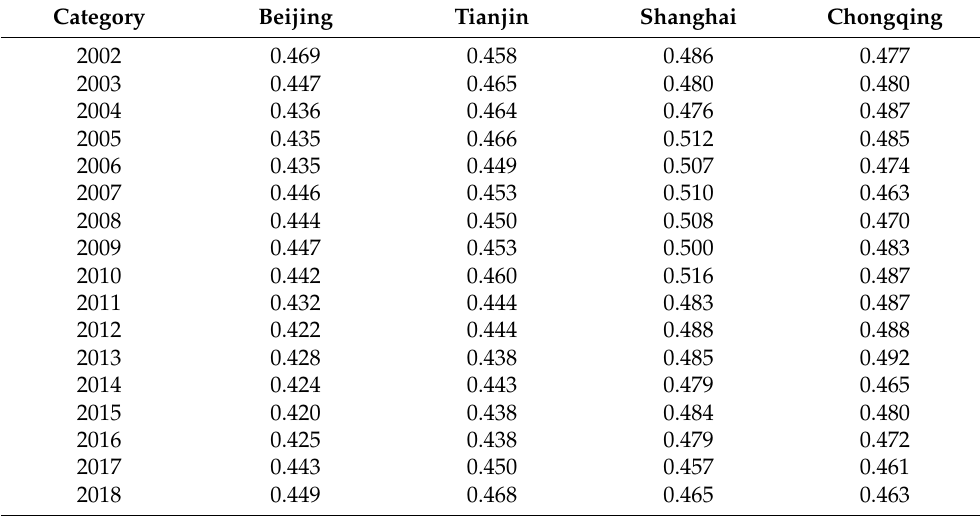
Table A5. Urban infrastructure resilience levels from 2002 to